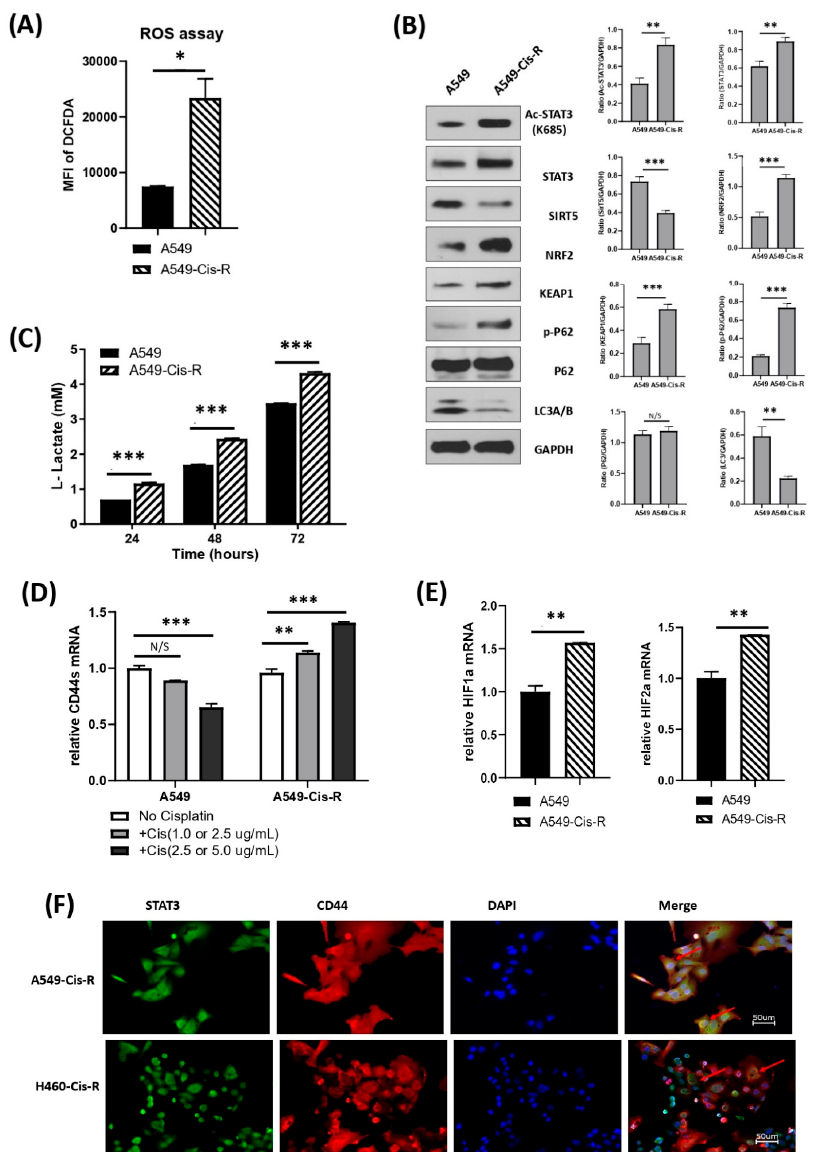
Figure 5. Changes in mitochondrial functions in the cisplatin-resistant clone of NSCLCs. ( A ) NSCLC cells (A549) and corresponding cisplatin-resistant cells (A549-Cis-R) were incubated with DCFDA solution. The cellular ROS levels were measured by mean of the mean fluorescence intensity (MFI) of DCFDA by flow cytometry. ( B ) The signaling molecules associated with mitochondrial functions were detected with whole lysates of A549 and A549-Cis-R. Data were quantified by densitometry using ImageJ and normalized to reference genes as loading control. ( C ) Equal volumes of super- natants from A549 cells and A549-Cis-R cells were applied to measure L-lactate production at same indicated time points with glycolysis assay. ( D ) A549 cells and A549-Cis-R cells were treated with indicated concentrations (A549: 1.0 µ g/mL, 2.5 µ g/mL; A549-Cis-R: 2.5 µ g/mL, 5.0 µ g/mL) for 24 h. Real-time quantitative RT-PCR was performed to measure the mRNA transcripts of CD44s gene. ( E ) Hif1 alpha and Hif2 alpha mRNA levels were determined by real-time quantitative PCR in A549 cells and A549-Cis-R cells. ( F ) Cisplatin-resistant cells (A549-Cis-R and H460-Cis-R) were stained simultaneously with anti-STAT3 and anti-CD44 antibodies integrated with different fluorescence. The nuclei were stained with DAPI. Data representative of 3 independent experiments for ( A , C – E ) or 2 for ( B , F ) with each PCR done in triplicate. Red arrows show the overlapping (yellow) areas of STAT3 and CD44. Statistical significances are indicated by: N/S not significant, * p < 0.05; ** p < 0.01; and *** p <